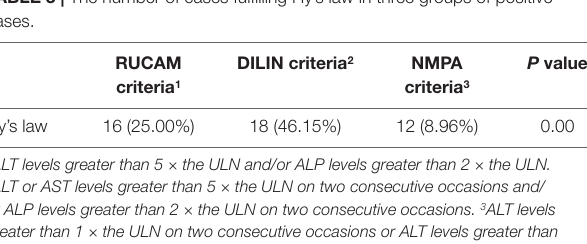
TABLE 4 | Agreement between the RUCAM criteria and DILIN